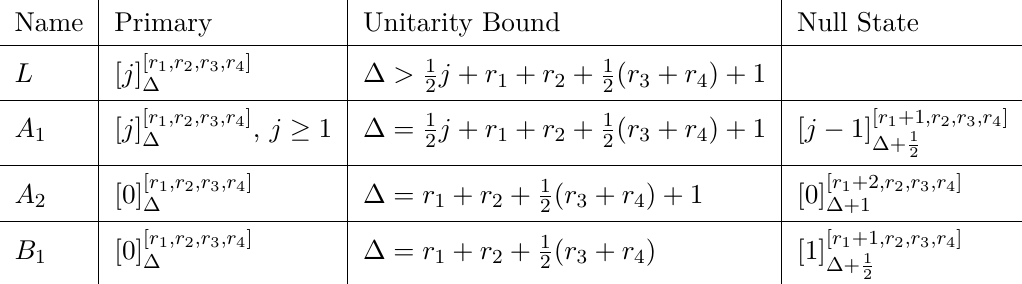
Table 1. Unitary multiplets of the 3d N = 8 superconformal algebra which is a real form of osp (8 | 4) . We follow the terminology of [81] — short multiplets of A-type are “at threshold” while those of B-type are “below threshold”. One could further refine the classification by counting how many supercharges annihilate each